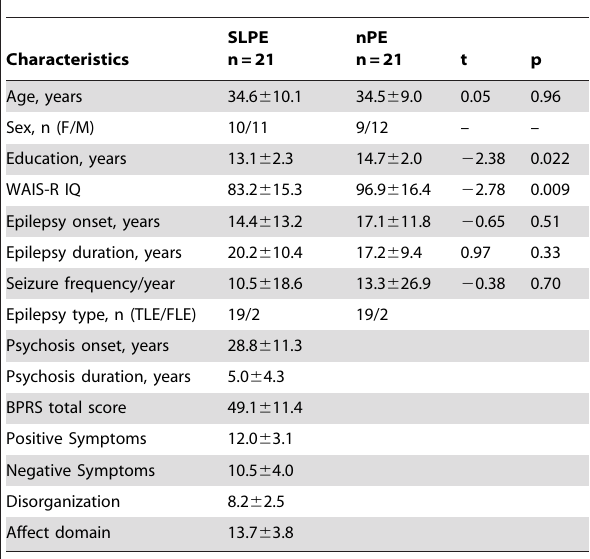
Table 1. Demographic and clinical